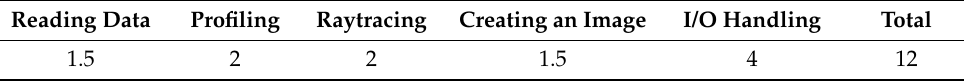
Table 2. Maximum run times (in seconds) involved in creating Table 1. Reading